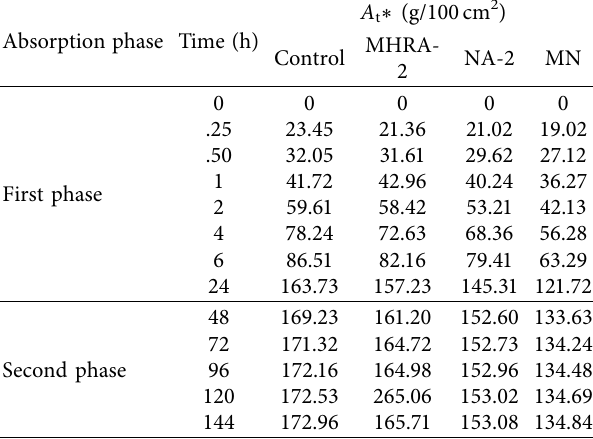
Table 3: Water absorption